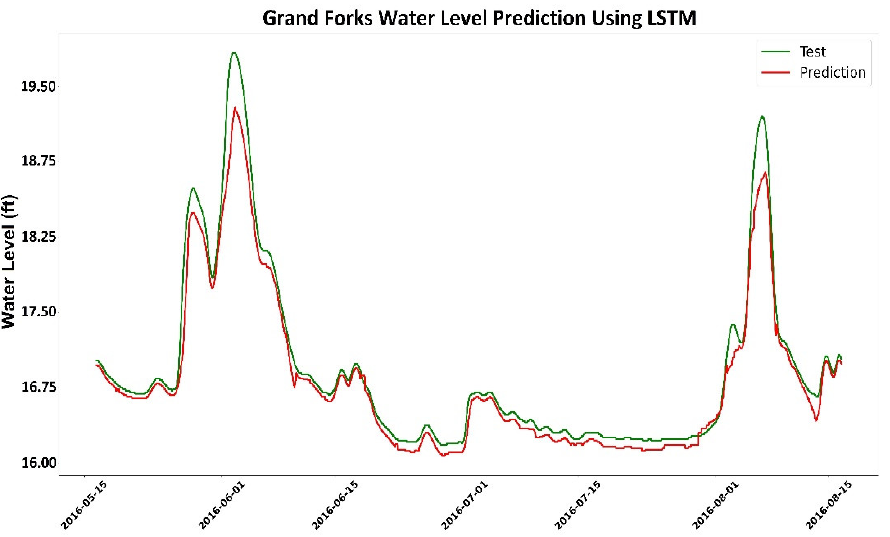
Figure 8. Visual comparison of 3 months of predicted values using LSTM forecasting method with true values on Grand Forks series.